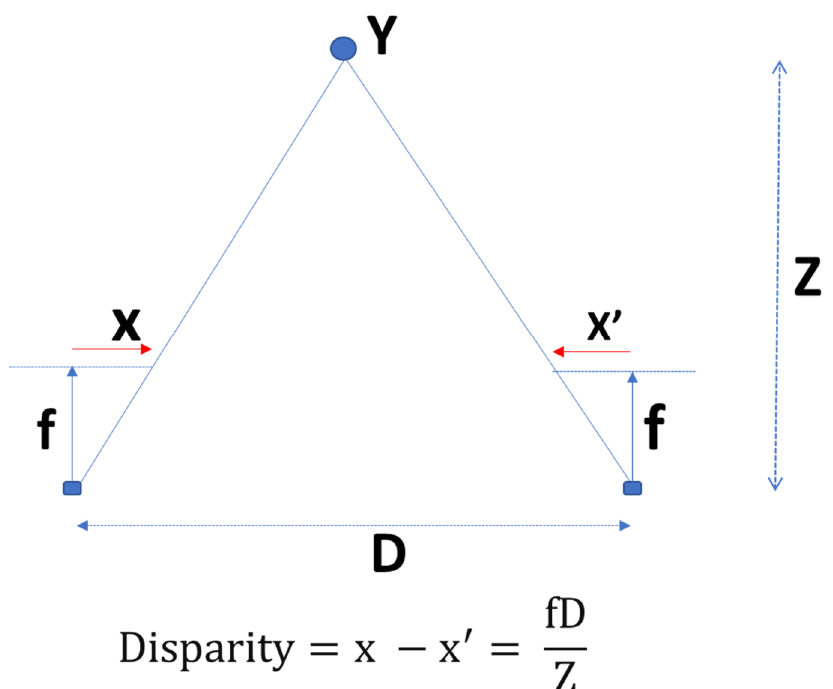
Figure 2. Disparity calculation. Where x and x’ are the distance between points in the image plane corresponding to the three-dimensional (3D) scene point and their camera center. D is the distance between two lenses of the stereo camera, and f is the focal length of both lenses. Y is the location of the object, whereas Z is the distance of the object to the camera.